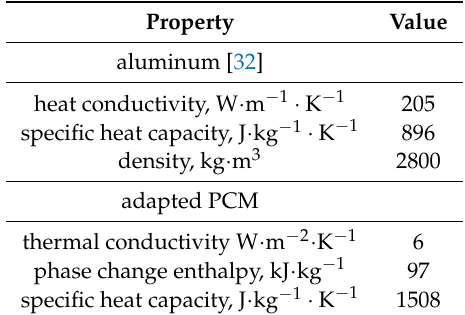
Table 5. Aluminum and adapted PCM